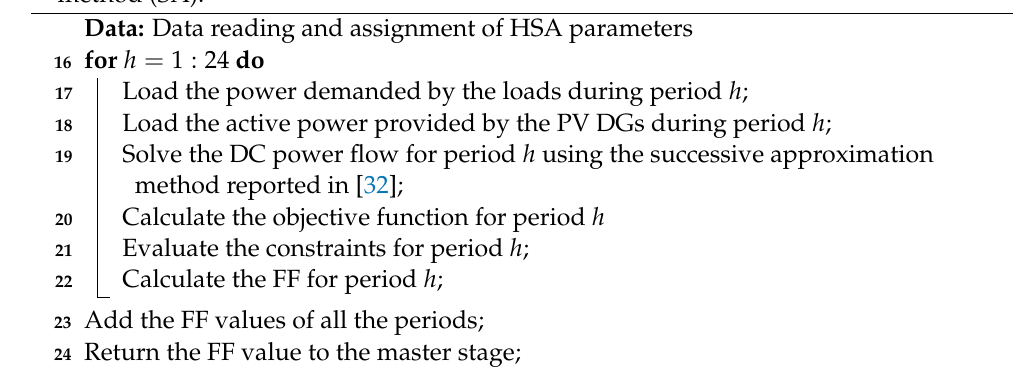
Algorithm 2: Traditional hourly power flow based on successive approximation method